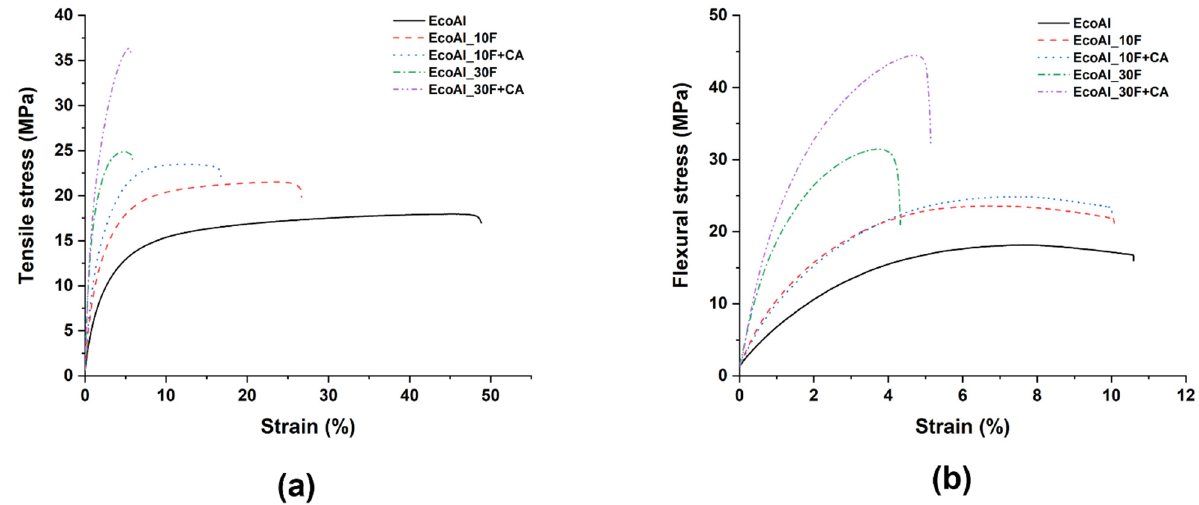
Figure 3. Representative ( a ) tensile and ( b ) three-point bending curves of EcoAllene-based composites.